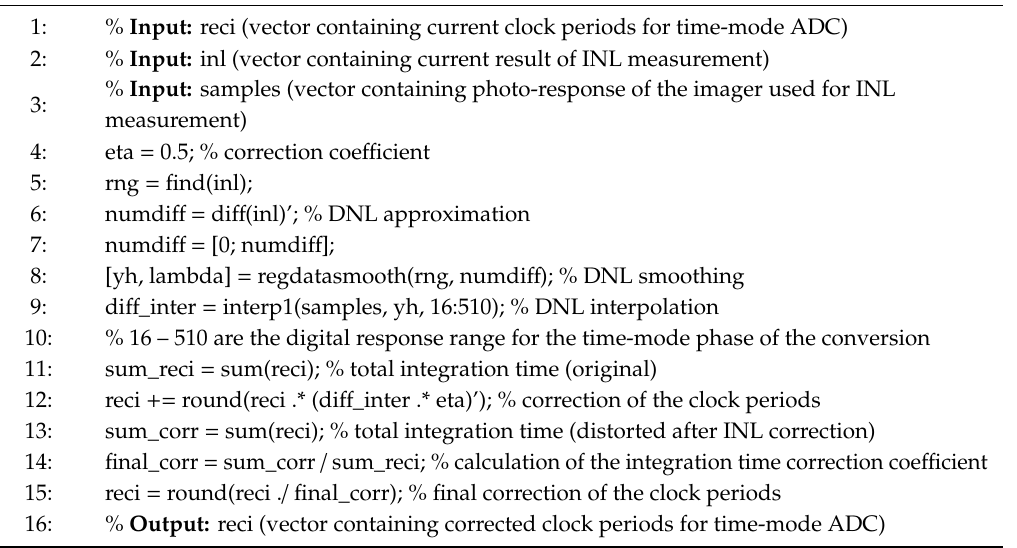
Algorithm 1. The Octave language code of the proposed linearity improvement algorithm